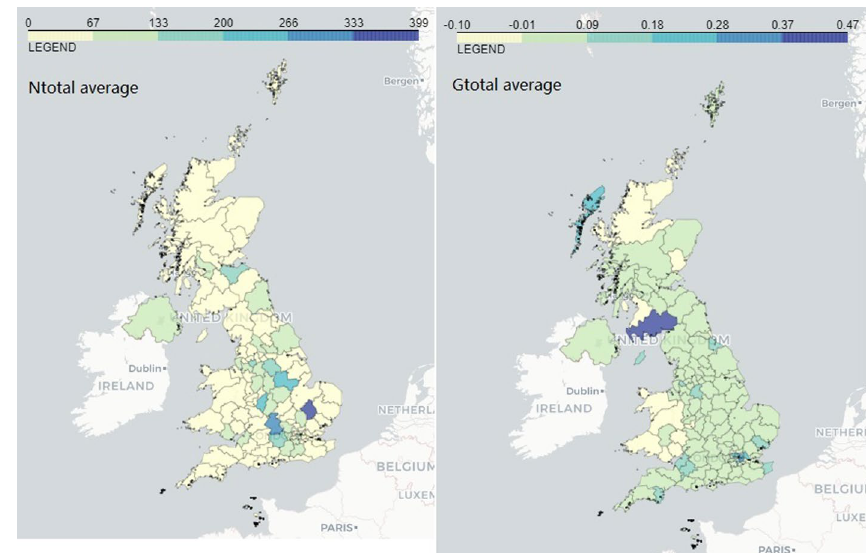
Fig. 3 UK postcode areas with numbers and growths of firms in the bioscience and health technology